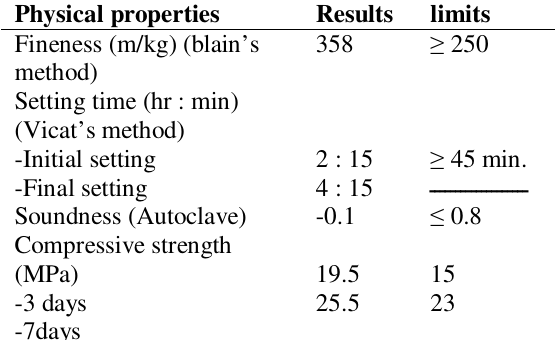
Physical properties of the cement.